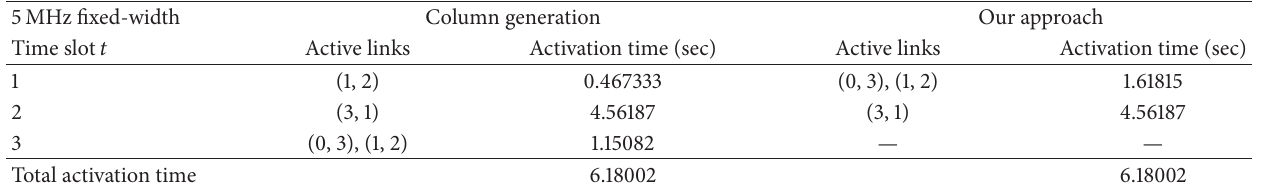
Table 2: Result of 5 MHz fixed-width channel allocation.